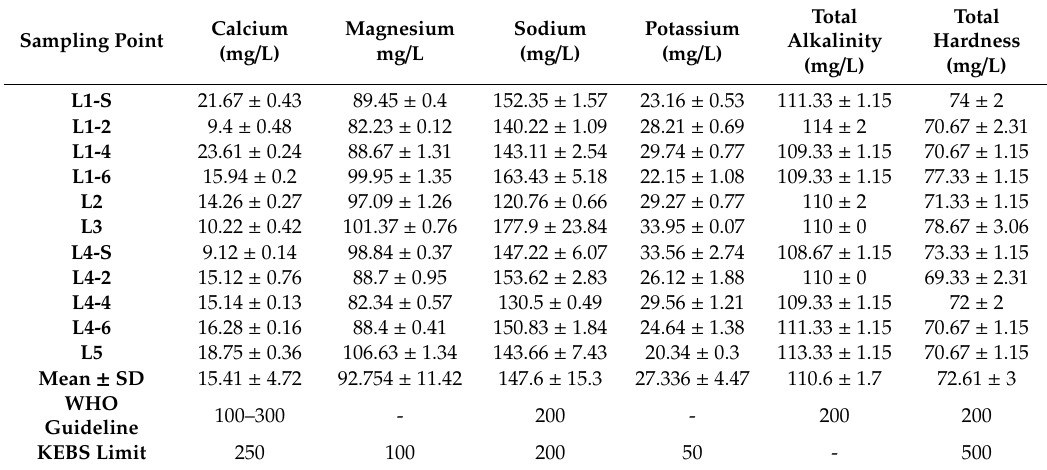
Table 7. Concentration of chemical parameters in Rungiri quarry reservoir in August 2019.